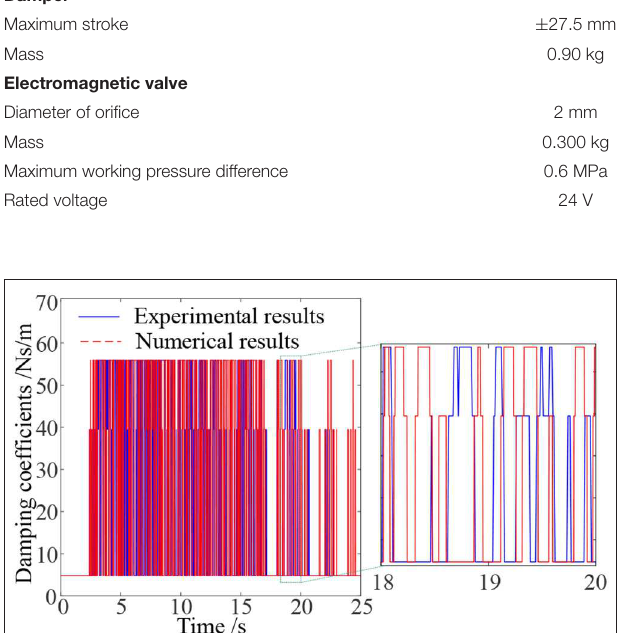
FIGURE 6 | The 2-DOF scaled down laboratory physical model of the Sosokan Building.